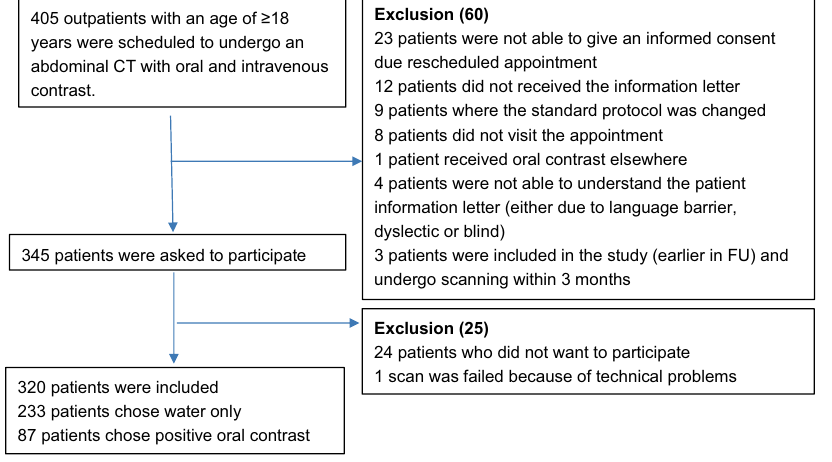
Figure 1. Selection and inclusion of